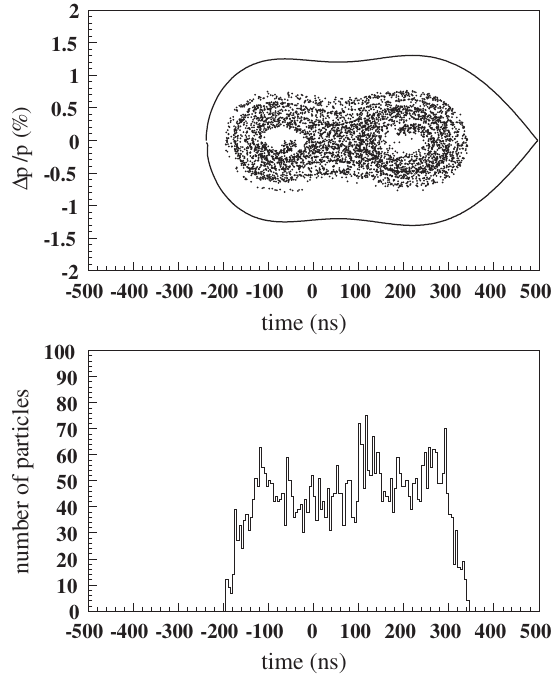
FIG. 1. A typical bunch shape after injection applying the second harmonic rf at the 1000th turn (beginning of the accel- eration). The ratio of the second harmonic to the fundamental is 80%.